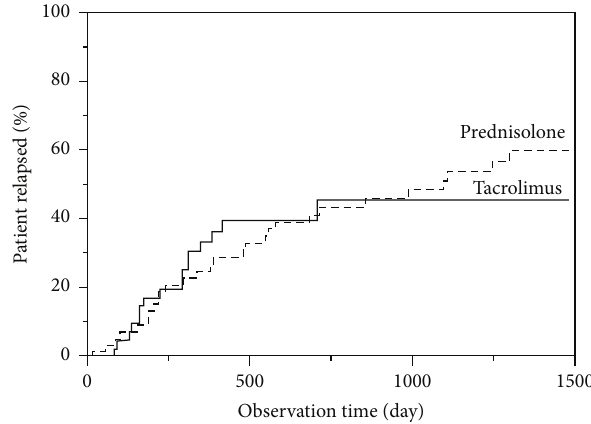
Figure 1: Cumulative relapse rate following remission induced by tacrolimus or by prednisolone in patients with ulcerative colitis.